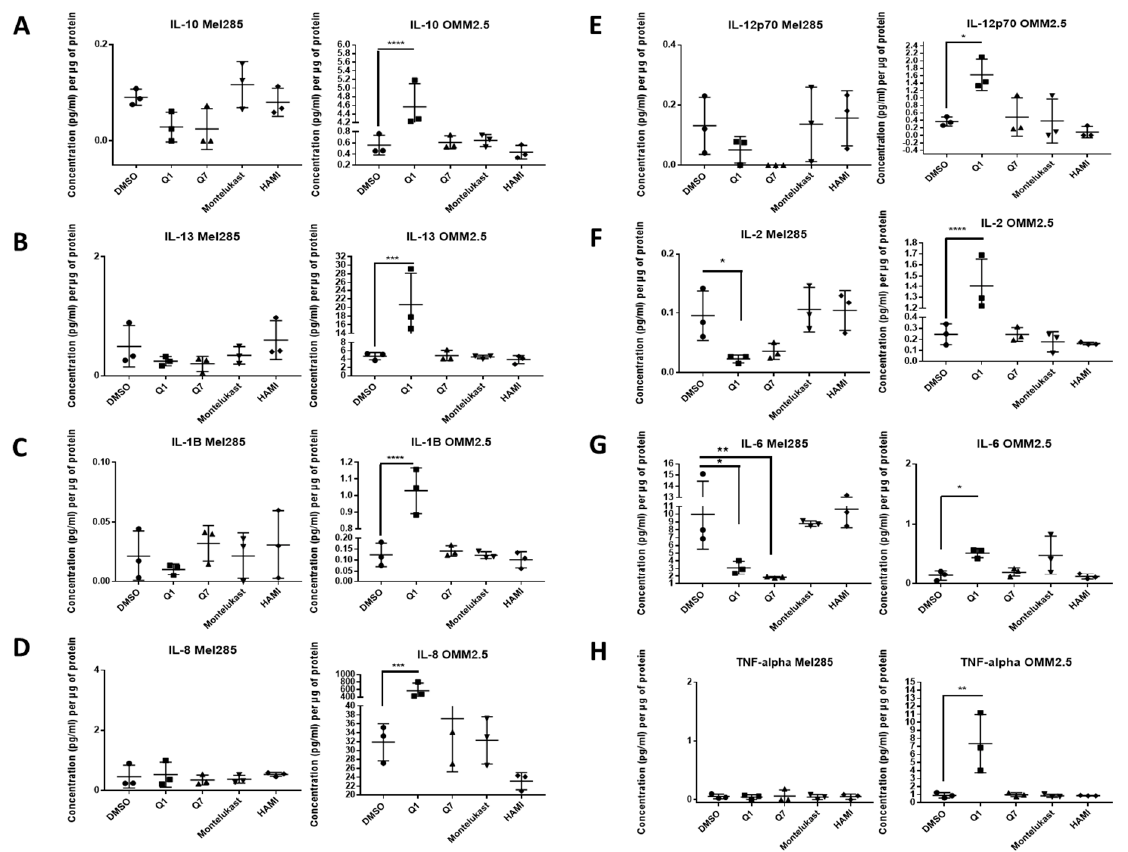
Figure 7. ELISA of cell conditioned media demonstrates that 24 h treatment with 20 µM quininib analogues decreases inflammatory markers in Mel285 cells but increases inflammatory markers in OMM2.5 cells. In OMM2.5 cells, 24 h treatment with quininib (Q1) significantly increased the secretion of IL-10 ( A ), IL-13 ( B ), IL-1B ( C ), IL-8 ( D ), IL-12p70 ( E ), IL-2 ( F ), IL-6 ( G ), and TNF- α ( H ). In Mel285 cells, 24-h treatment with 20 µM quininib (Q1) and 1,4–dihydroxy quininib (Q7) significantly reduced the levels of IL-2 ( F ) and IL-6 ( G ). Treatment with 20 µM montelukast or HAMI 3379 had no effect on the secretion of inflammatory markers in either cell line. Conditioned media were collected from three separate experiments and analysed by ELISA ( n = 3). All secretions were normalised to total protein content. Statistical analysis was performed by ANOVA with Dunnett’s post hoc multiple comparison test. Error bars are mean + S.E. * p < 0.05; ** p < 0.01; *** p < 0.001; **** p < 0.0001. In the metastatic OMM2.5 cell line, treatment with 20 µ M quininib significantly upregulated